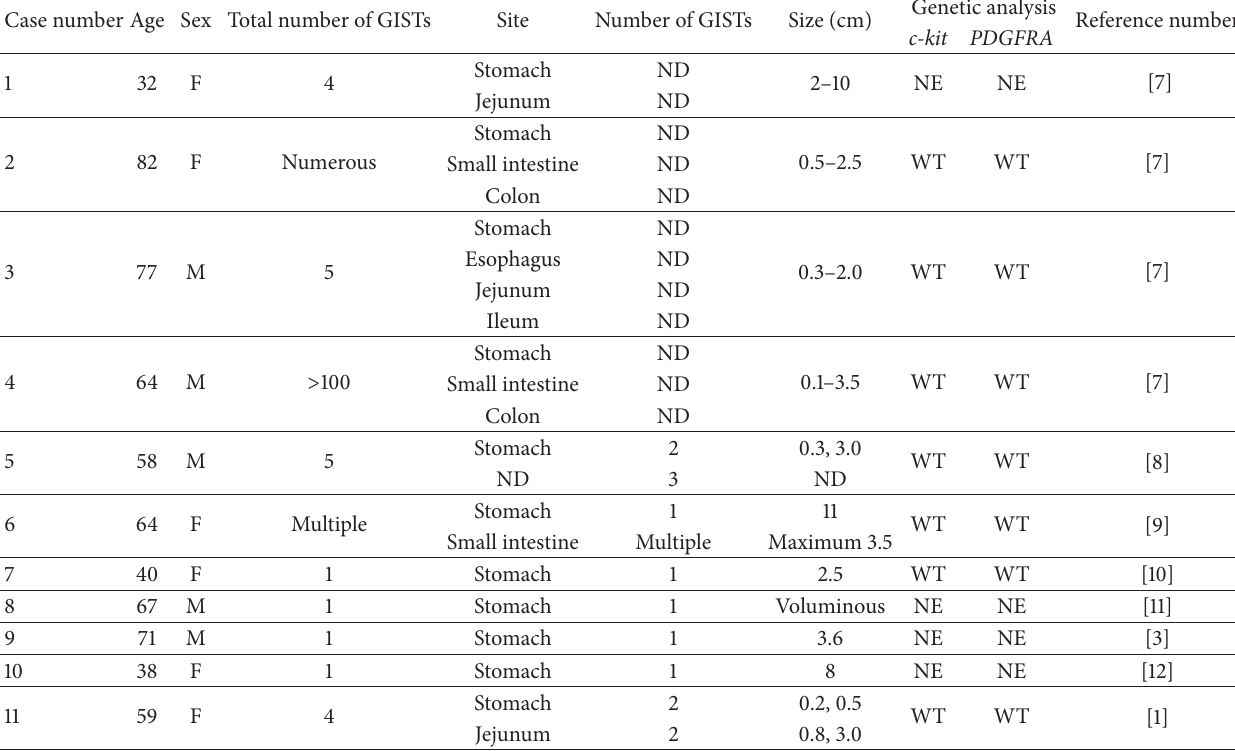
Table 1: Cases of gastric GISTs in patients with NF